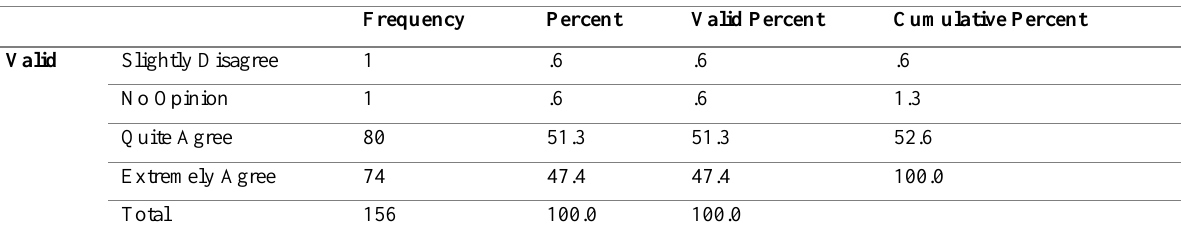
Table 7: Perceived usefulness of MyCO